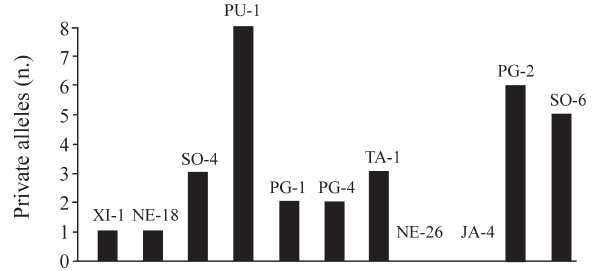
Figure 4 - Number of private alleles for the 11 Brazilian Oryza glumaepatula